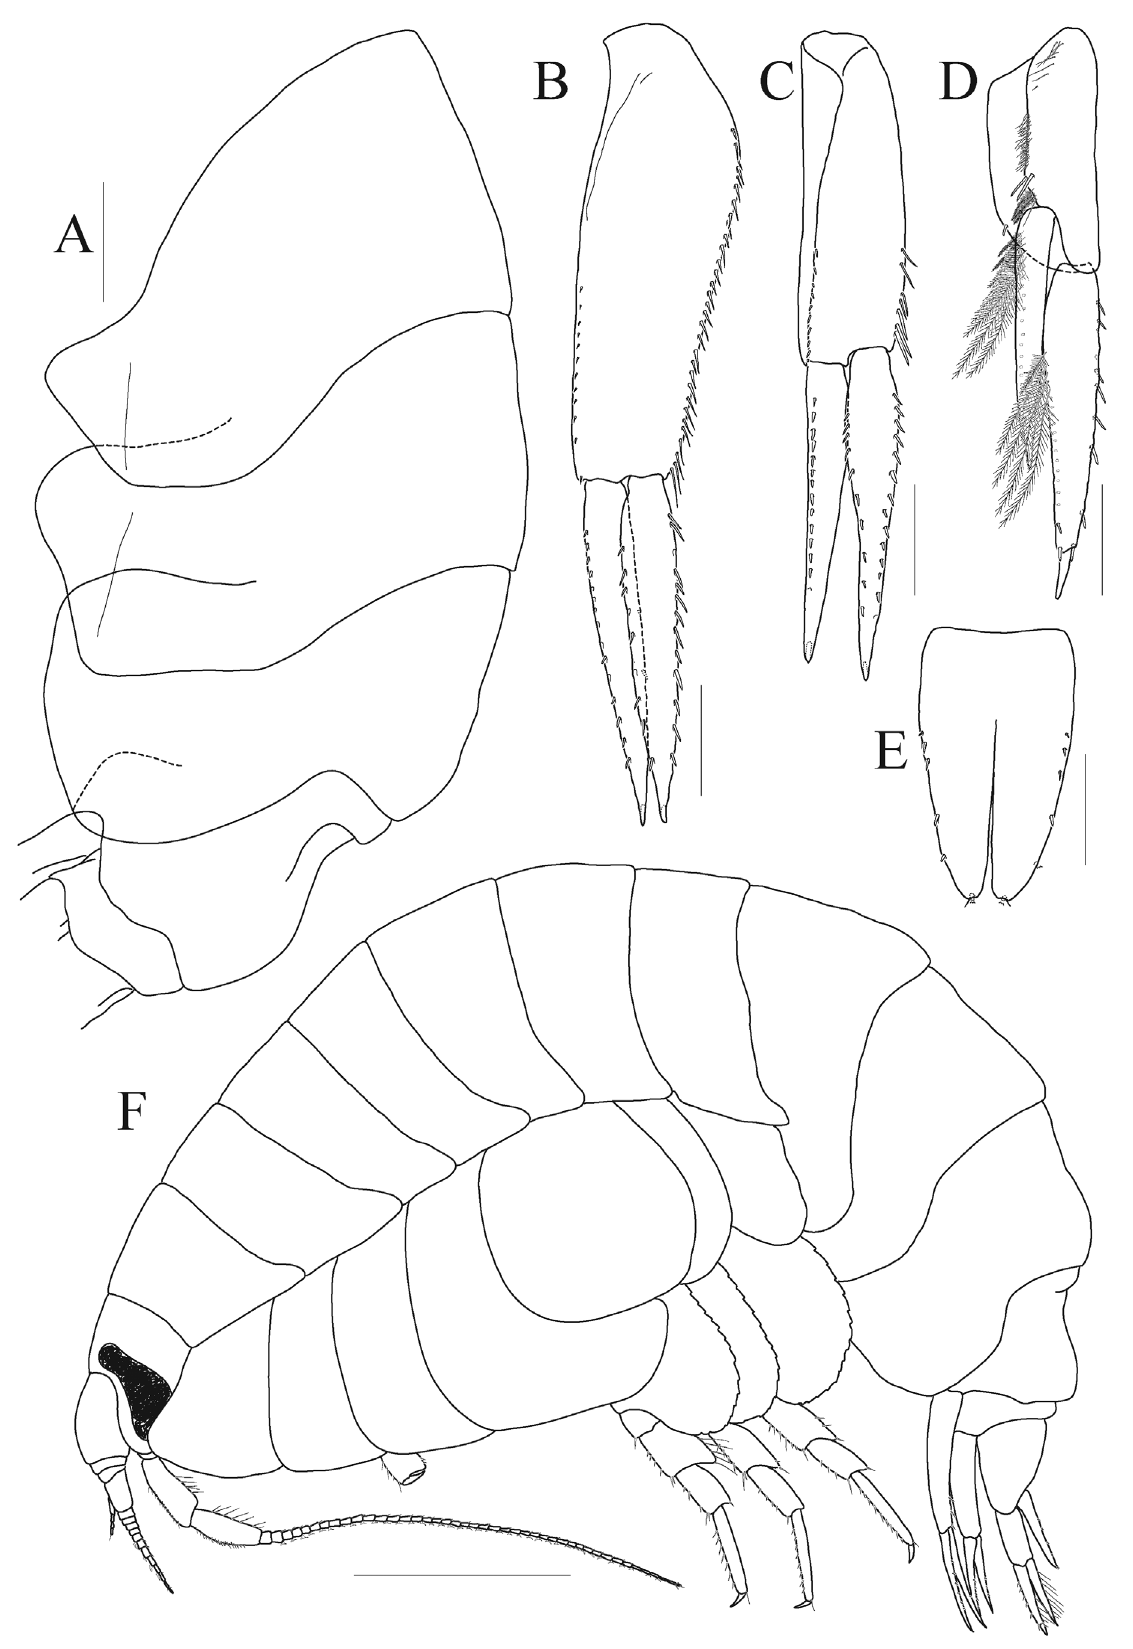
Figure 5. Pseudorchomene boreoplebs sp. n., holotype female (27.1 mm; A–E ), NIBRIV0000806535 and paratype male (18 mm; F ), NIBRIV0000807159. A pleon, lateral; B uropod 1; C uropod 2; D uropod 3; E telson; F habitus of male. Scale bars 0.5 mm ( B–E ), 1.0 mm ( A ), 2.0 mm ( F